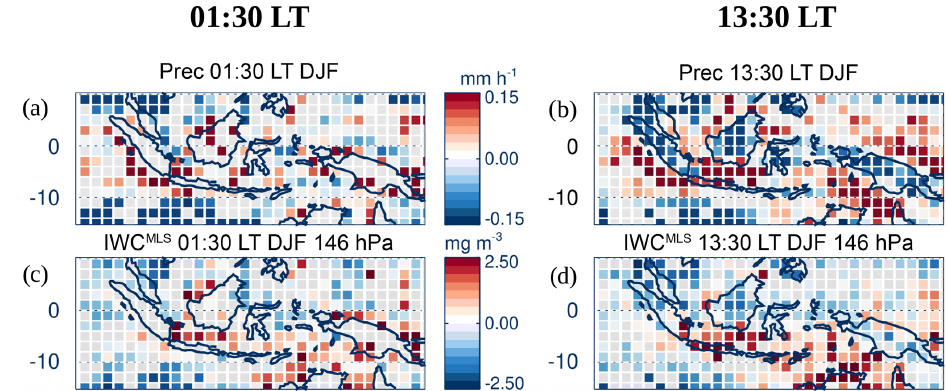
Figure 3. Anomaly (deviation from the mean) of Prec (a–b) and ice water content (IWC MLS ) at 146hPa (c–d) , at 01:30 (a) and at 13:30LT (b) over pixels where 01:30 and 13:30LT are during the growing phase of the convection, respectively, averaged over the period of DJF 2004–2017. The grey colour denotes pixels for which convection is not ongoing.